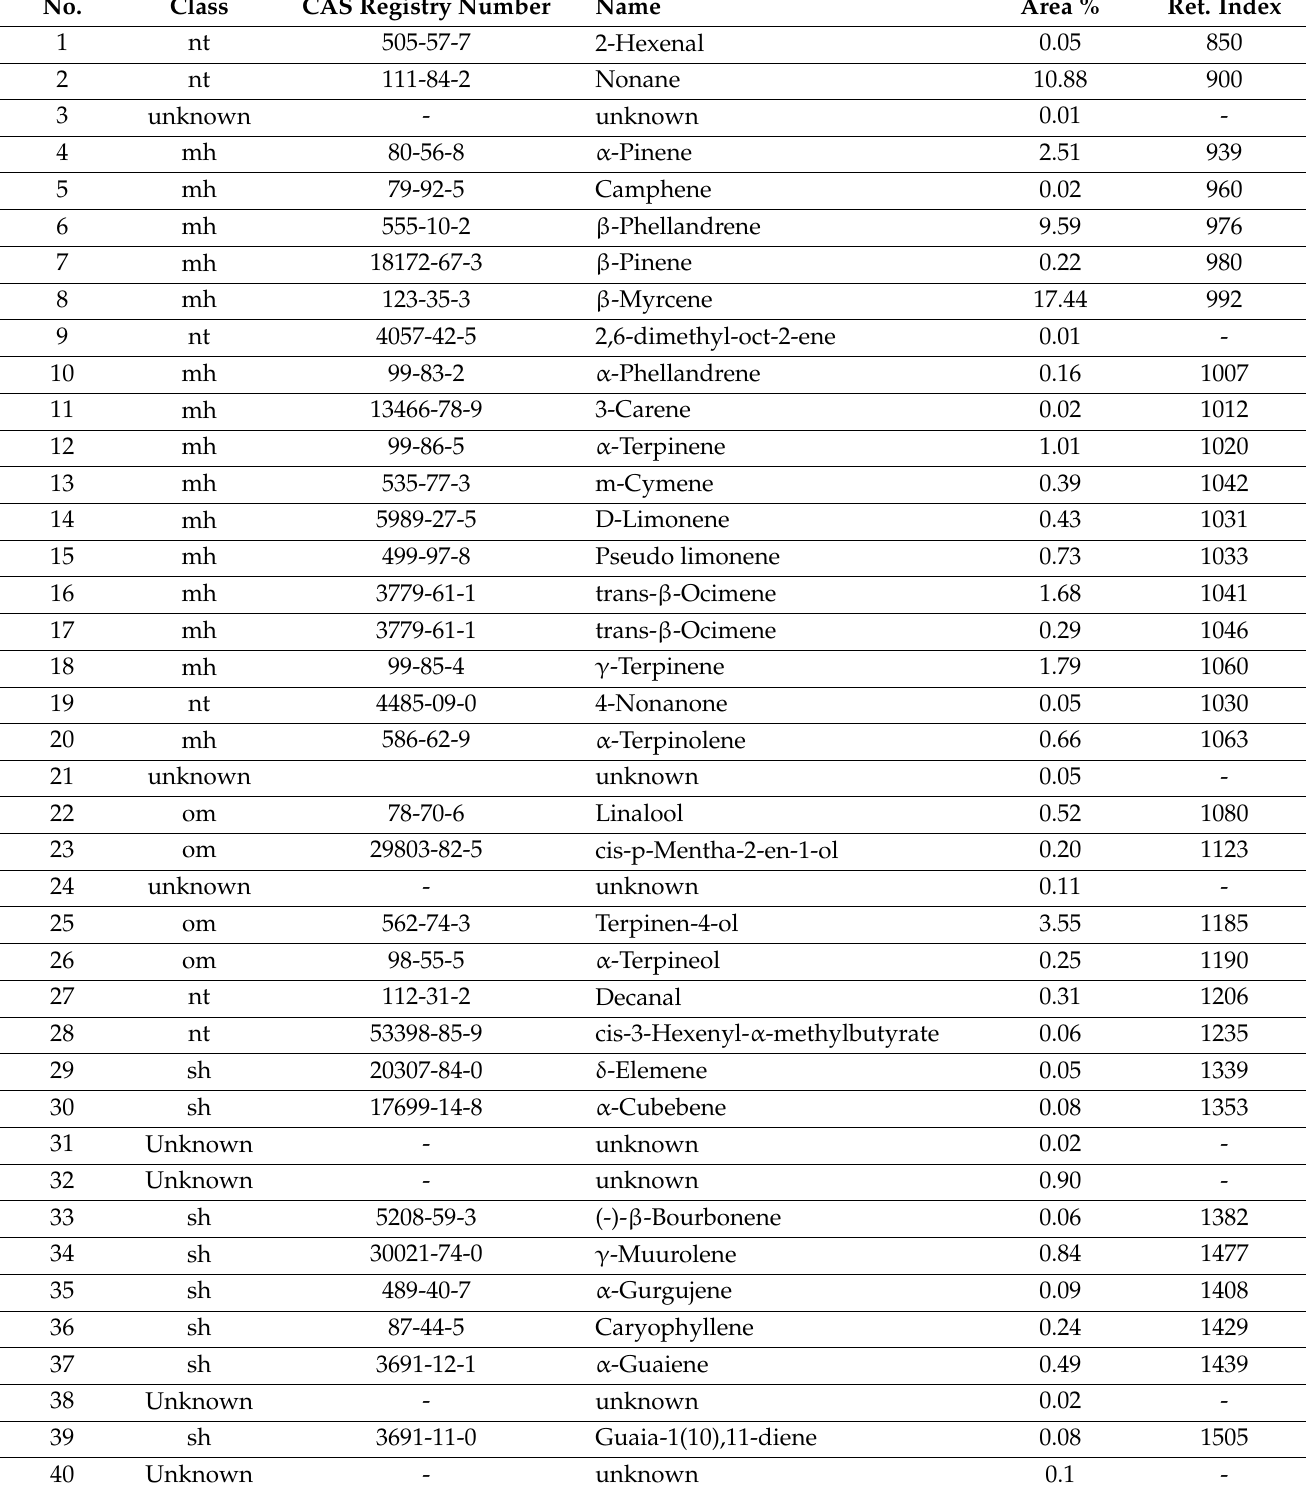
Table 2. GC-MS analysis of the essential oil of aerial parts of C. gileadensis